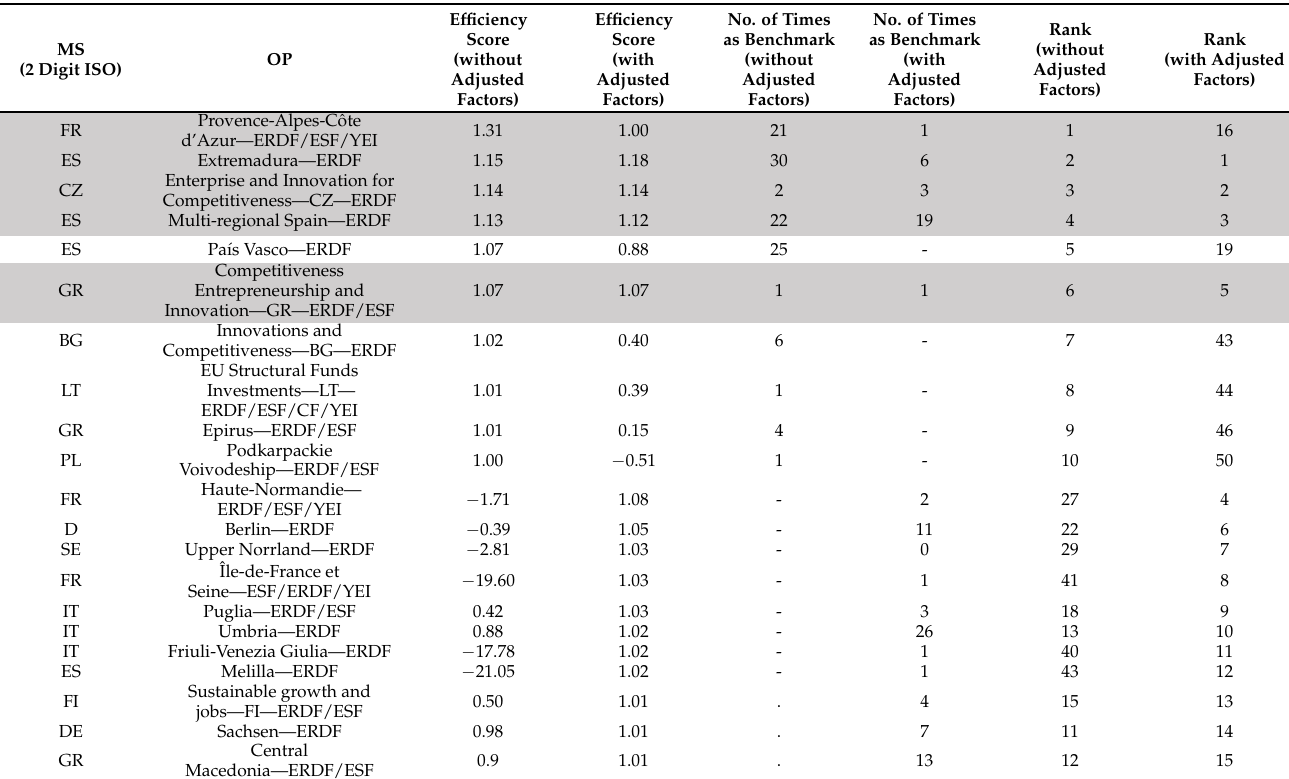
Table 13. Main characteristics of efficient OPs obtained with and without the adjusted